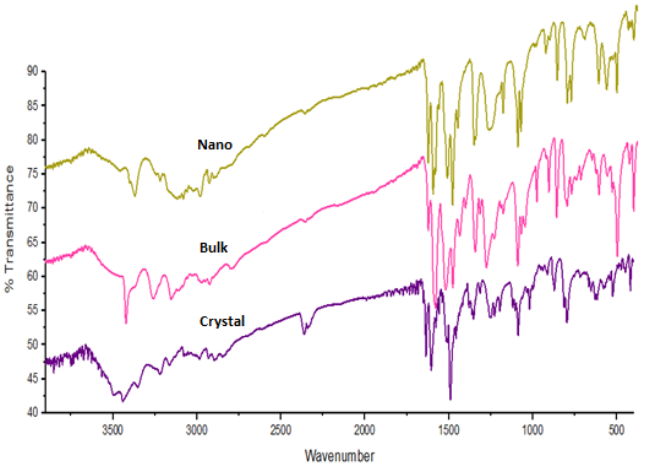
Figure 2. FTIR spectra of the coordination compound [Bi(HQ)(Cl) 4 ] n in nano, bulk, and crystalline form.